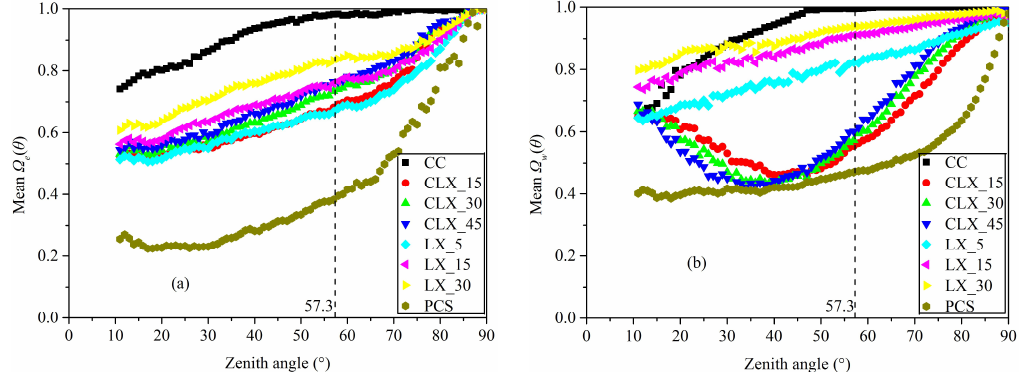
 and ( )  derived from CC, CLX, LX, and PCS at the six leaf-on Figure A1. Mean ( ) e w Figure A1. Mean Ω e ( θ ) and Ω w ( θ ) derived from CC, CLX, LX, and PCS at the six leaf-on coniferous coniferous scenes with reference scenes with reference Ω e > 1 ( a ) and five leaf-off deciduous scenes with reference Ω w > 1 ( b ),